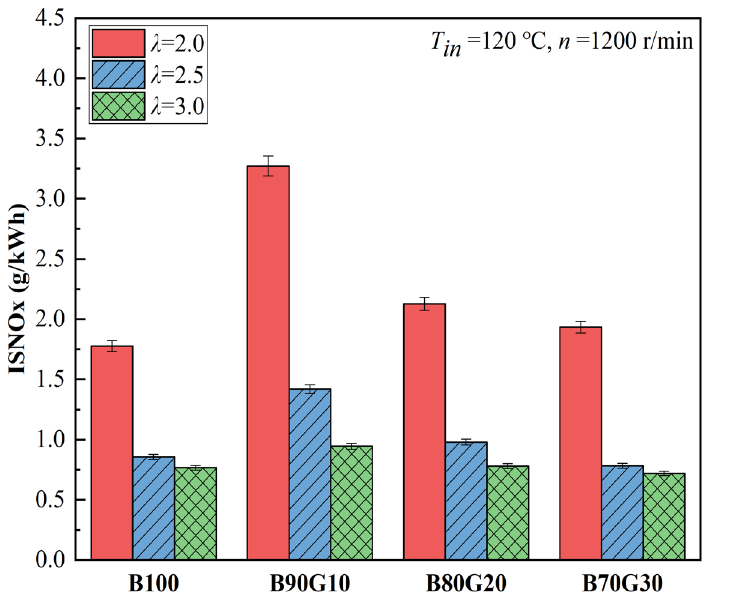
Figure 8. NOx emissions with different λ